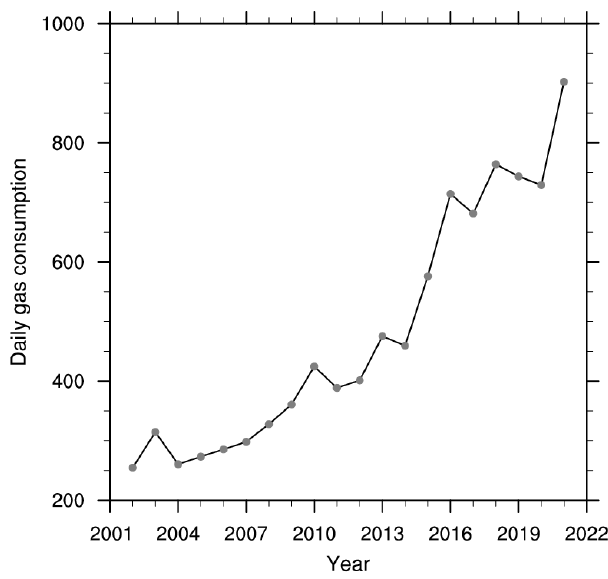
Figure 1. Time series of the daily average natural gas consumption (unit: m 3 ) during heating season for the period of 2002–2021 in Beijing.